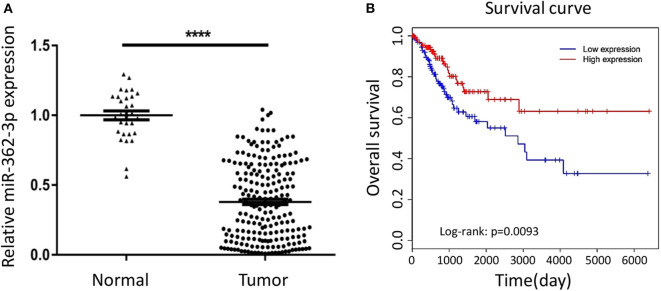
MiR-362-3p is lowly expressed in cervical cancer tissues and correlated with patient survival. (A) Expression of miR-362-3p in 208 human cervical cancer tissues and 30 normal adjacent tissues. Datas are the relative expression normalized to U6. ****P < 0.0001. (B) Kaplan–Meier survival curve showing overall survival of cervical cancer patients with low or high levels of miR-362-3p expression from TCGA database.